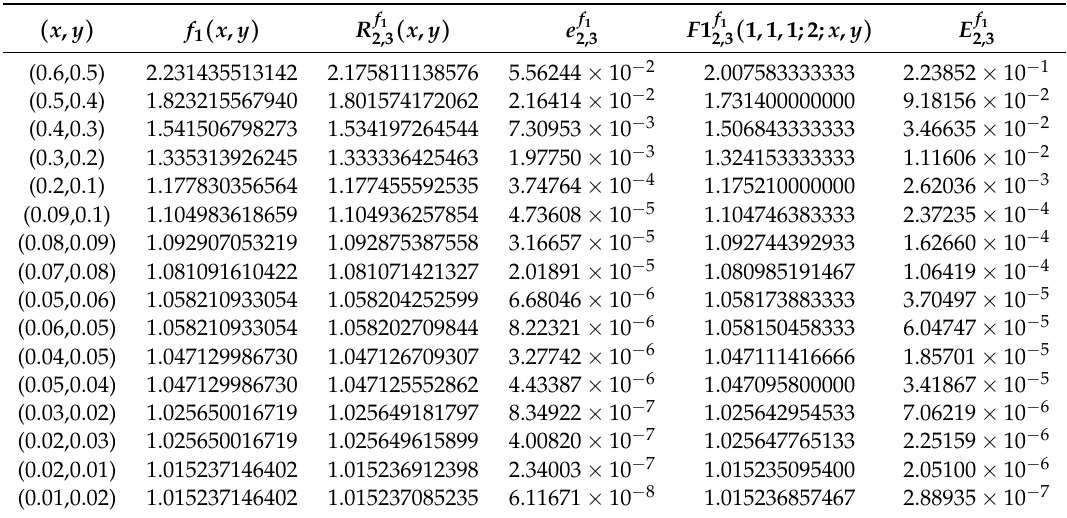
( x , y ) and F 1 f 1 ( 1,1,1;2; x , y ) . 2,3 2,3